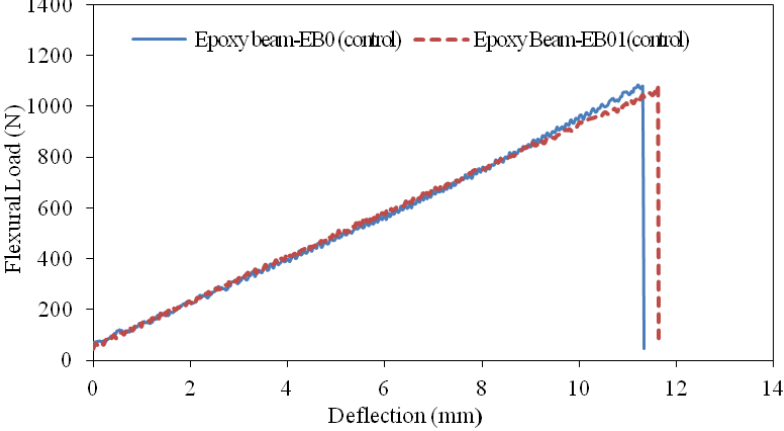
Figure 3. Flexural load-mid-span deflection curves of control epoxy beams.